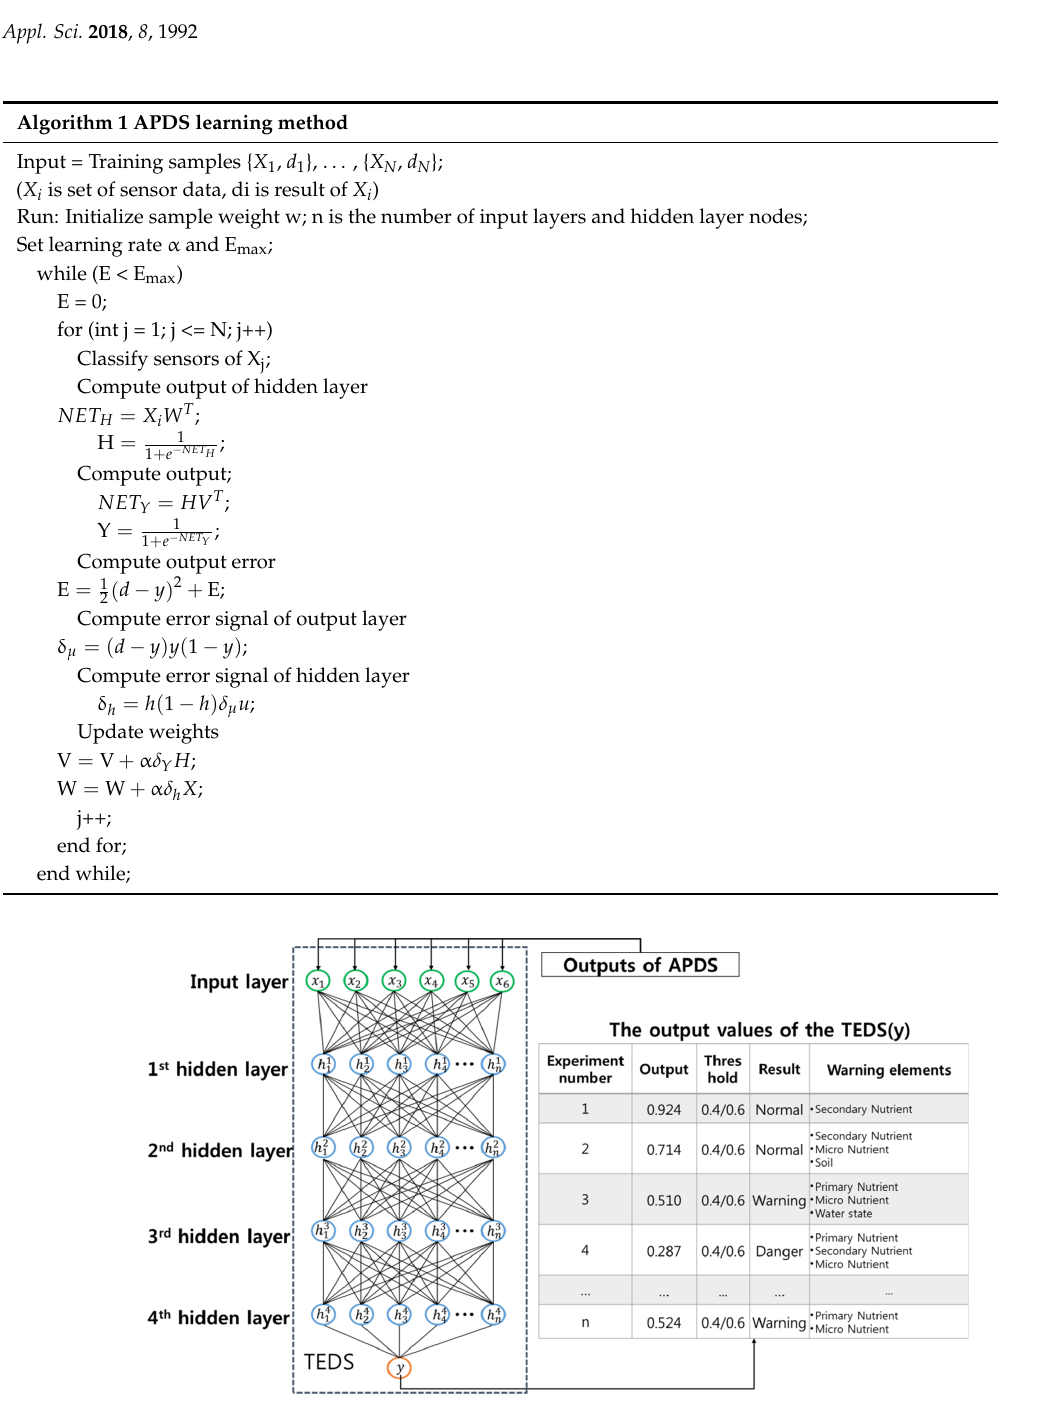
Figure 10. The example of the integrated model in the total environment diagnosis sub-module